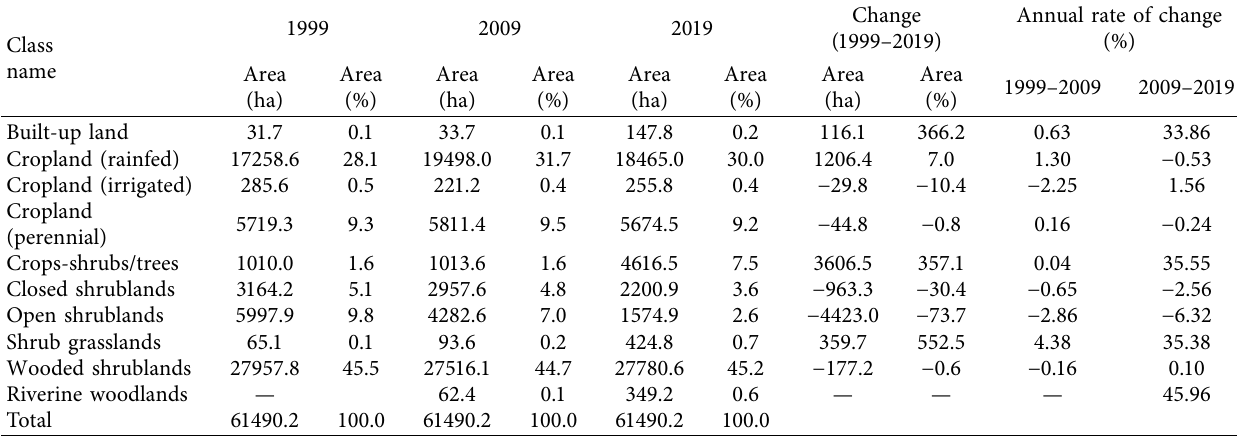
Table 7: LULC changes from 1999 to